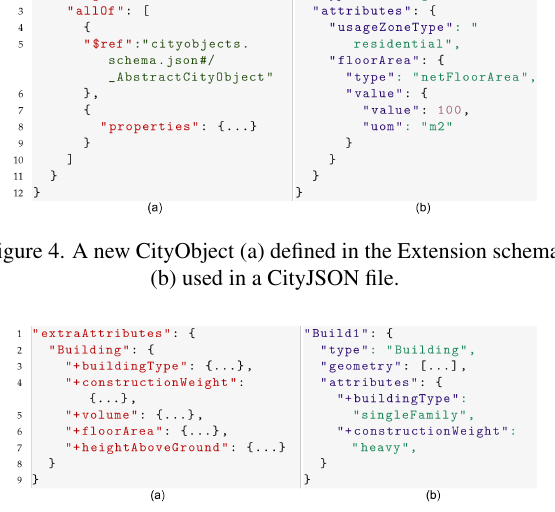
Figure 5. Extra attributes for Building objects (a) defined in the Extension schema, (b) used in a CityJSON